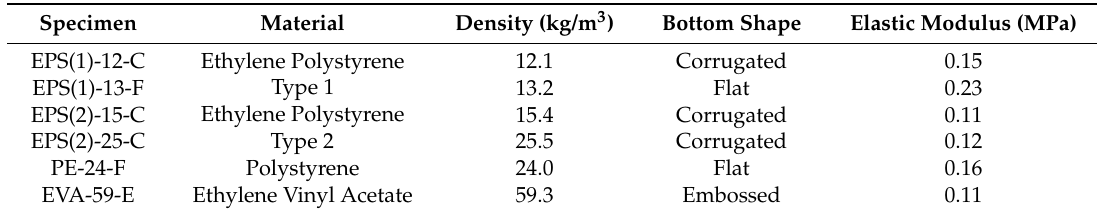
Figure 1. Bottom shape and cross-section of the six resilient materials. Table 1. Details of specimens.